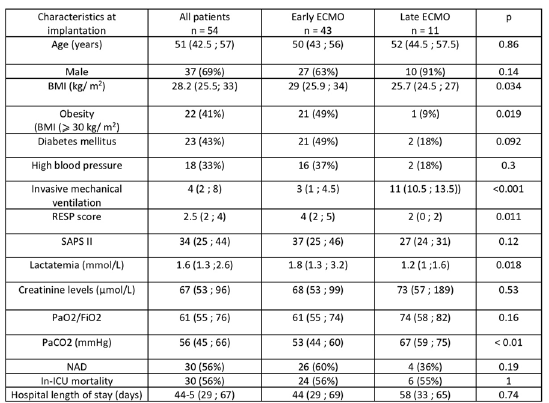
Figure 1: Time course of diaphragmatic function from D1 to ECMO wean- ing. Values are presented as medians with their standard deviations. The red line corresponds to the threshold of 11 cmH 2 O below which diaphrag- matic dysfunction is defined. CO‑51 Impaired pharmacokinetics of amiodarone under veno‑venous extracorporeal membrane oxygenation: from bench to bedside LESCROART Mickael 1 , PRESSIAT Claire 2 , PEQUIGNOT Benjamin 1 ,